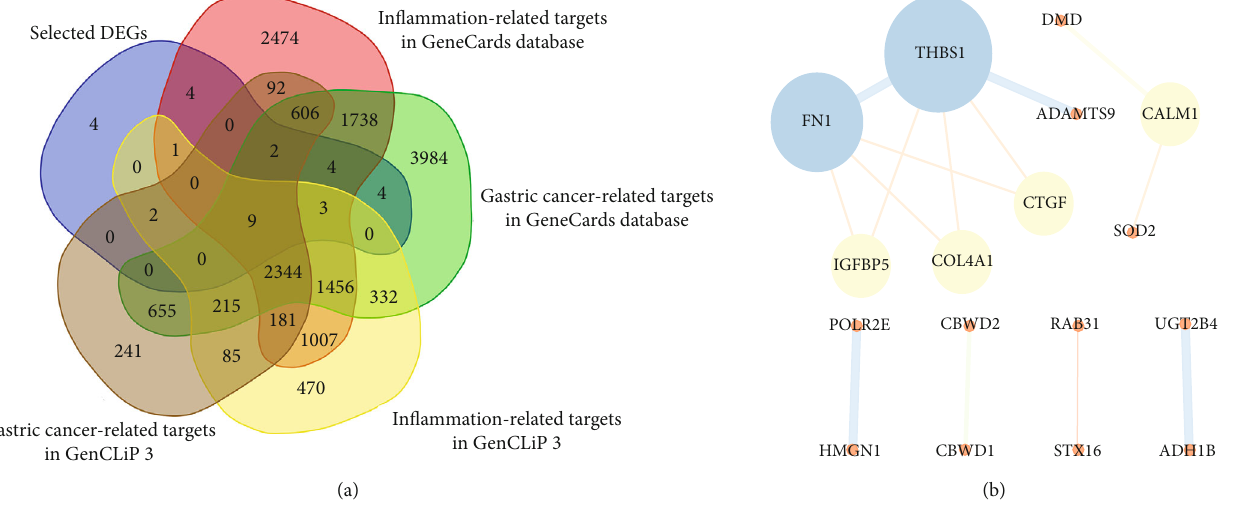
Figure 5: The identi fi cation of in fl ammation-related targets in GC by Venn diagram and PPI analysis: (a) Venn diagrams of the in fl ammation-related targets between the selected DEGs and the integrated GC-/in fl ammation-related targets in the GeneCards and GenCLiP 3 database; (b) the PPI network of 33 coexisting DEGs. Nodes represent genes, with the degree shown by the size and bright colors, and edges represent interactions between two genes, with the combined scores displayed by the size and bright